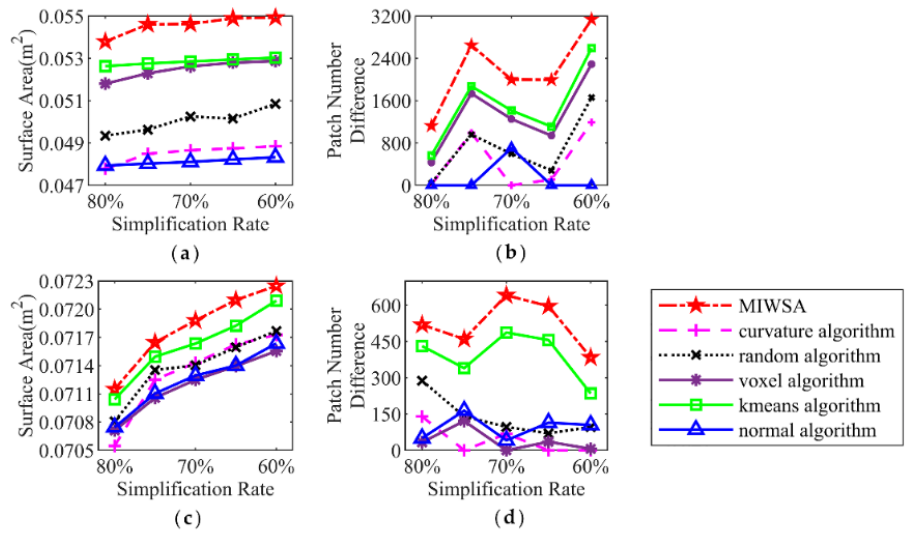
Figure 7. Surface area and patch numbers of the encapsulated surfaces: ( a ) encapsulated surface areas of Samp52; ( b ) encapsulated surface patch numbers of Samp52; ( c ) encapsulated surface areas of Samp52; ( d ) encapsulated surface patch numbers of Samp52.